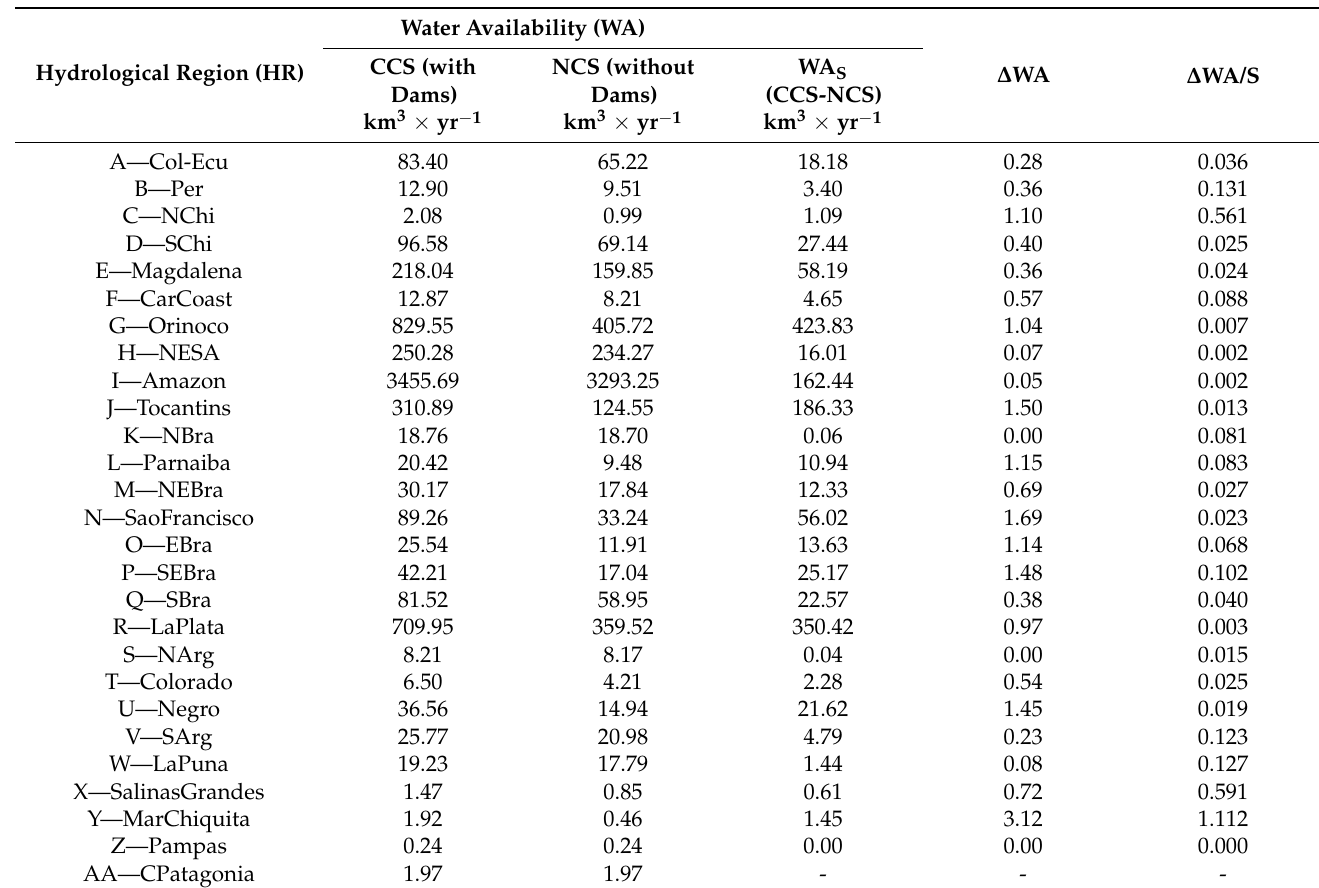
Table 3. Water availability scenarios considered for this